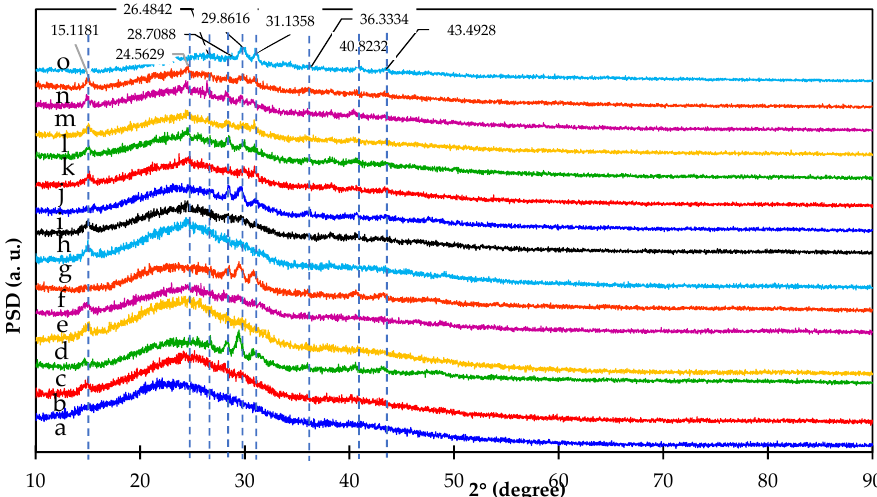
Figure 4. XRD patterns of ( a ) activated carbon w/t HTP prepared at 300 °C; ( b ) activated carbon w/t